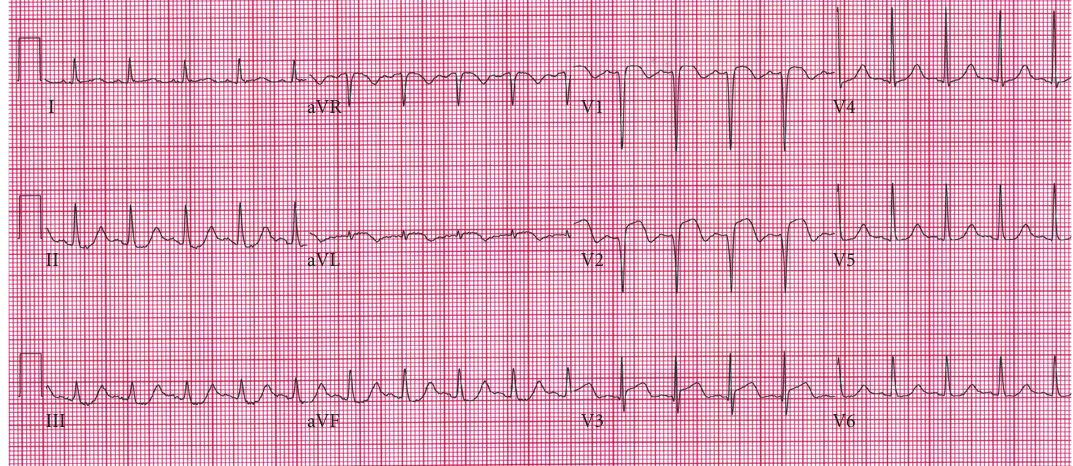
Figure 1: Significant ST segment elevation in precordial leads V1–V3 noted at the time of patient presentation.